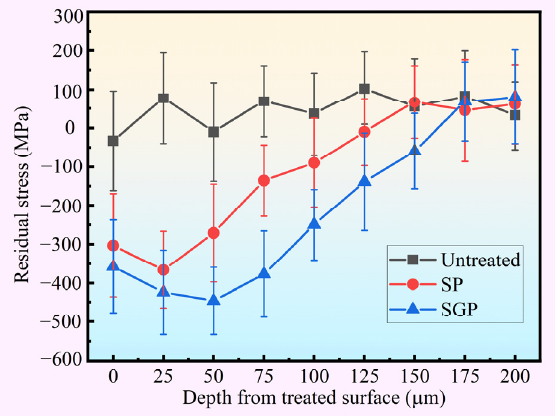
Figure 7. The residual stress distribution in the depth direction of the untreated, SP and SGP sam- ples.